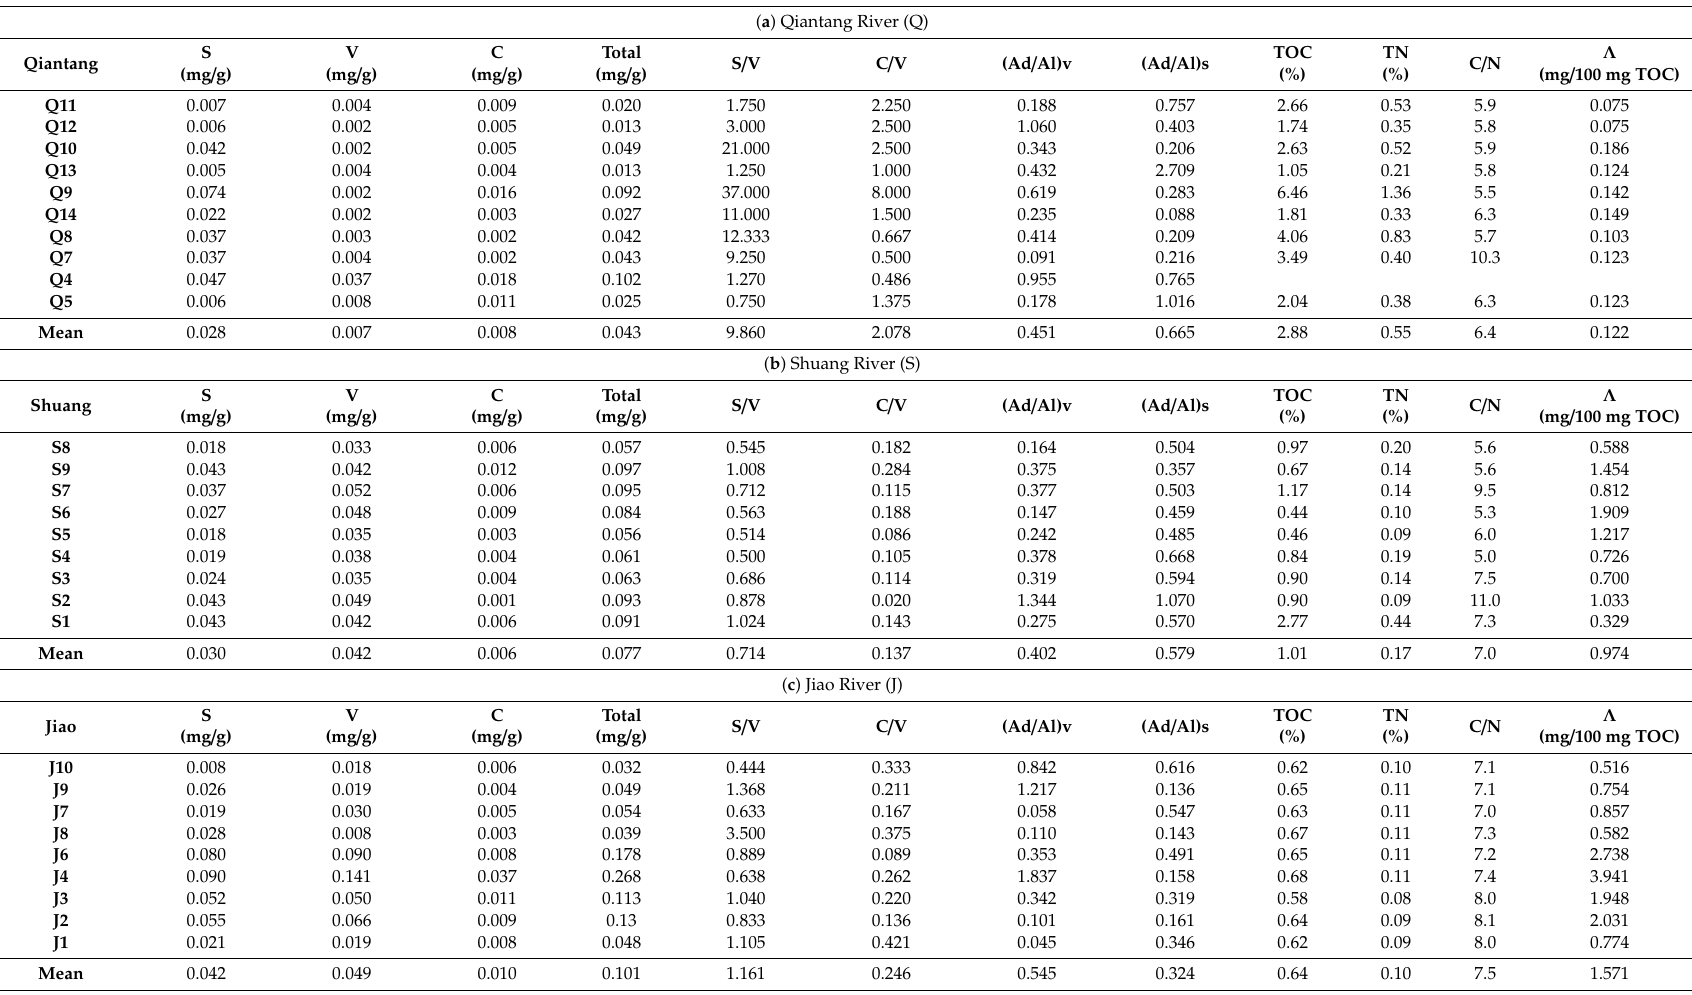
Table A2. Lignin parameters, TOC, TN and C / N ratios along ( a ) Qiantang River (Q), ( b ) Shuang River (S), ( c ) Jiao River (J), ( d ) Ximen Island (X), ( e ) Feiyun River (F), ( f ) Ao River